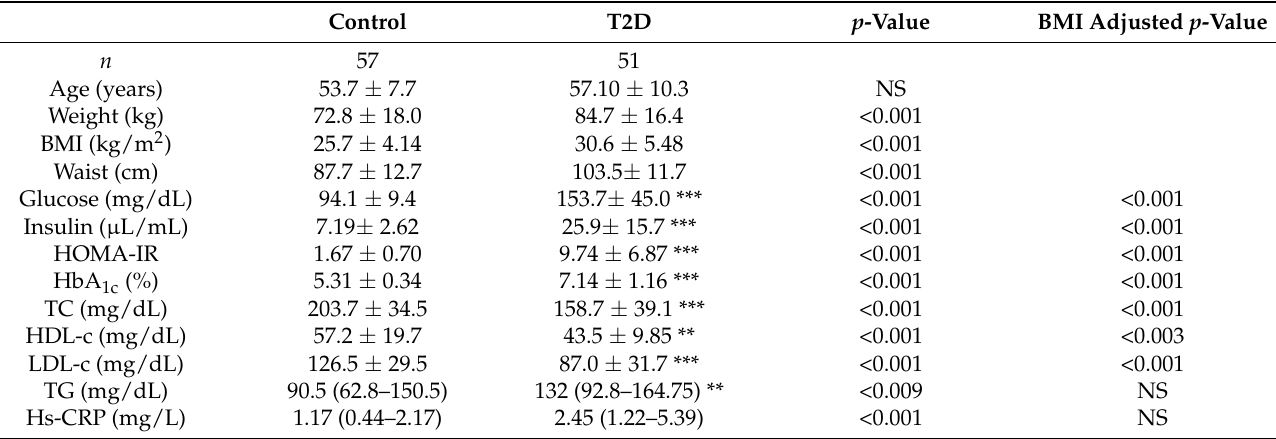
Table 1. Anthropometric and biochemical